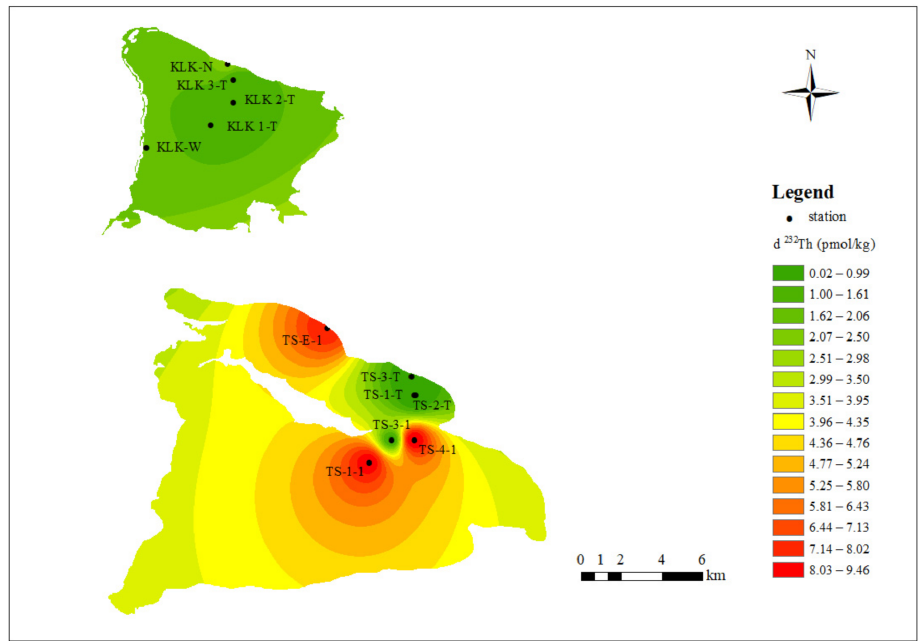
Figure 2. Surface distribution features of dissolved 232 Th concentration in Tuosu Lake and Keluke